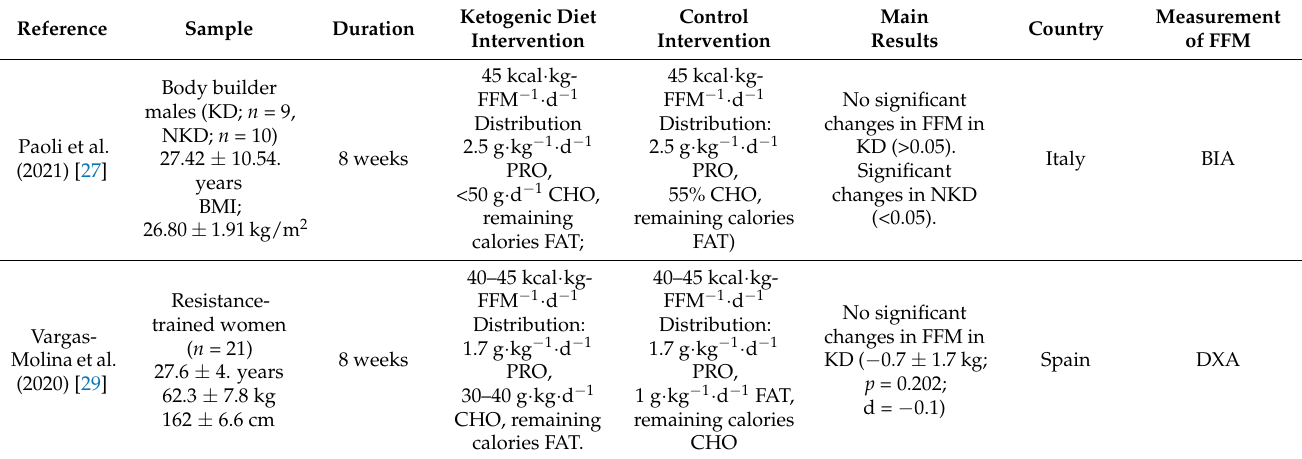
Table 1. Characteristics of five randomized controlled clinical